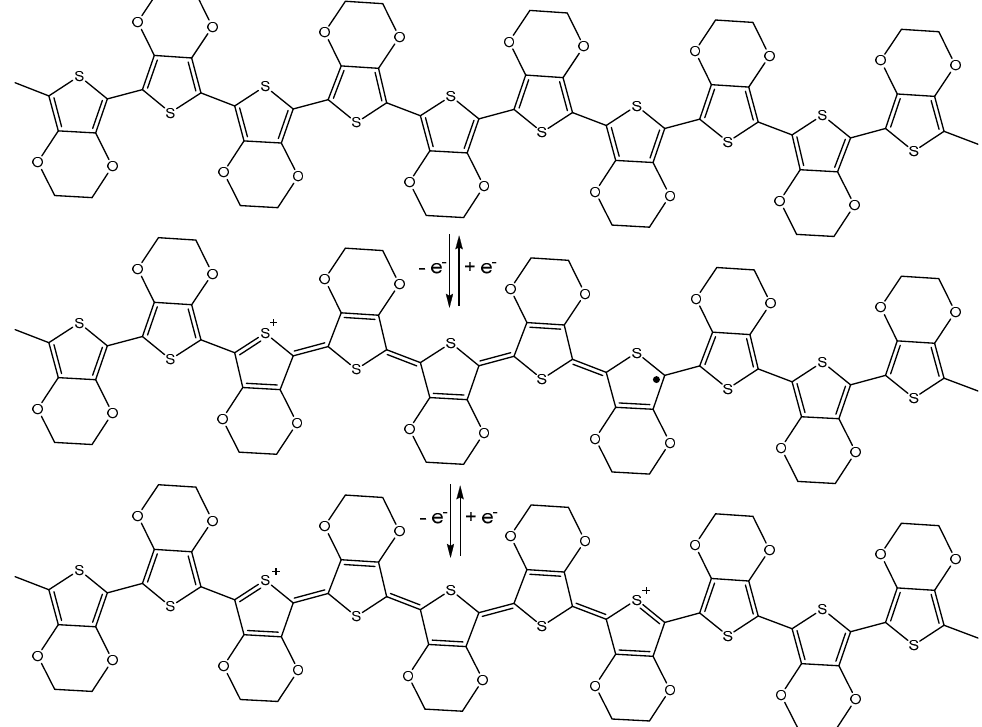
Figure 4. Removal of an electron from neutral PEDOT (top) results in formation of the PEDOT polaron (middle). Removal of a second electron results in the formation of the PEDOT bipolaron (bottom). These processes are reversible.